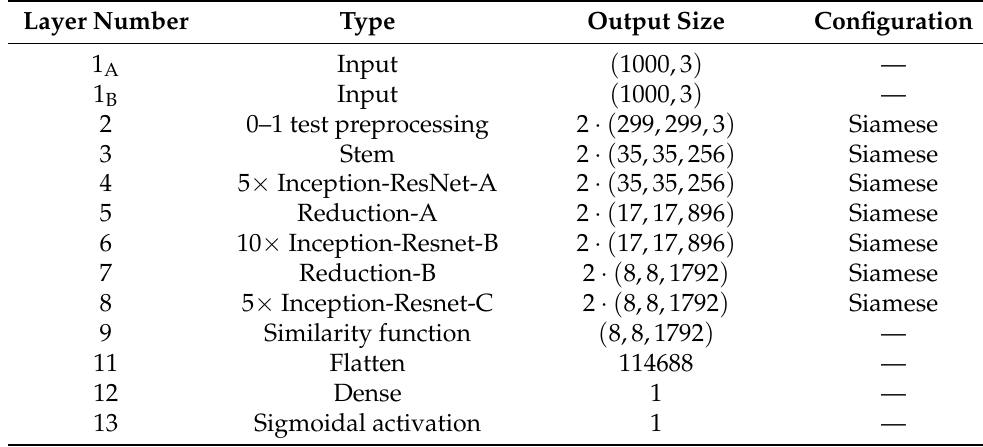
Table 1. Detailed architecture of the proposed CNN (convolutional neural network) Layer